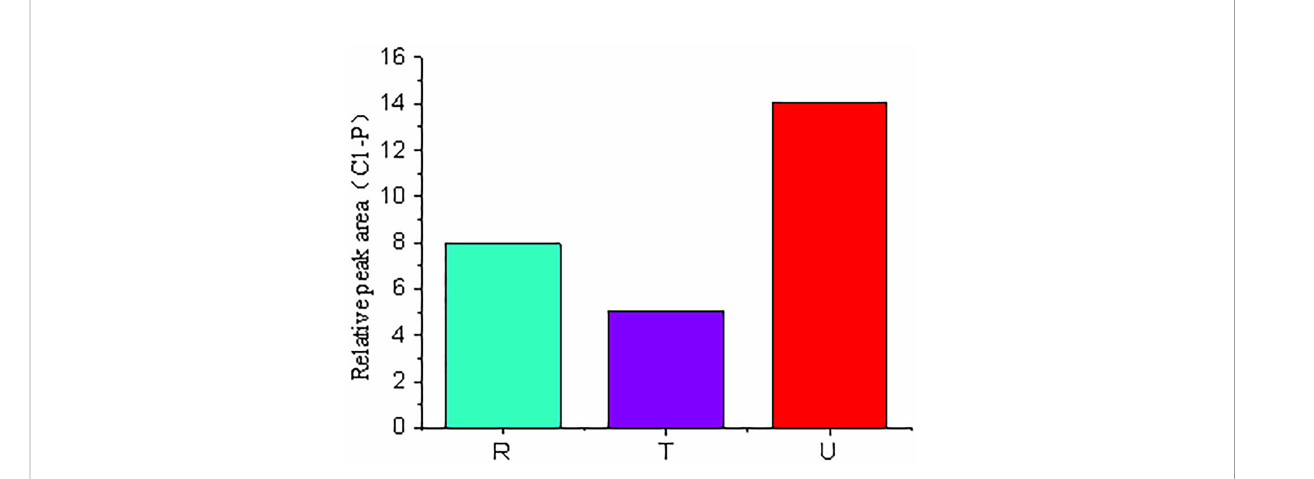
FIGURE 3 Comparison of the relative abundance of C1-P in fresh oils (three kinds of crude